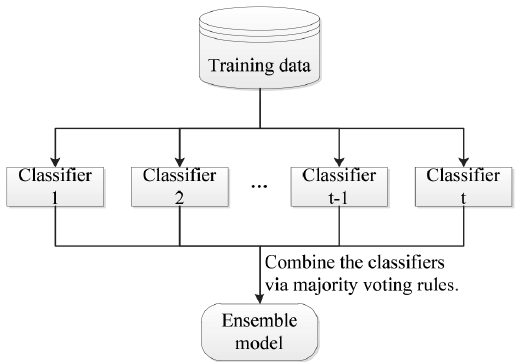
Figure 2. Ensemble